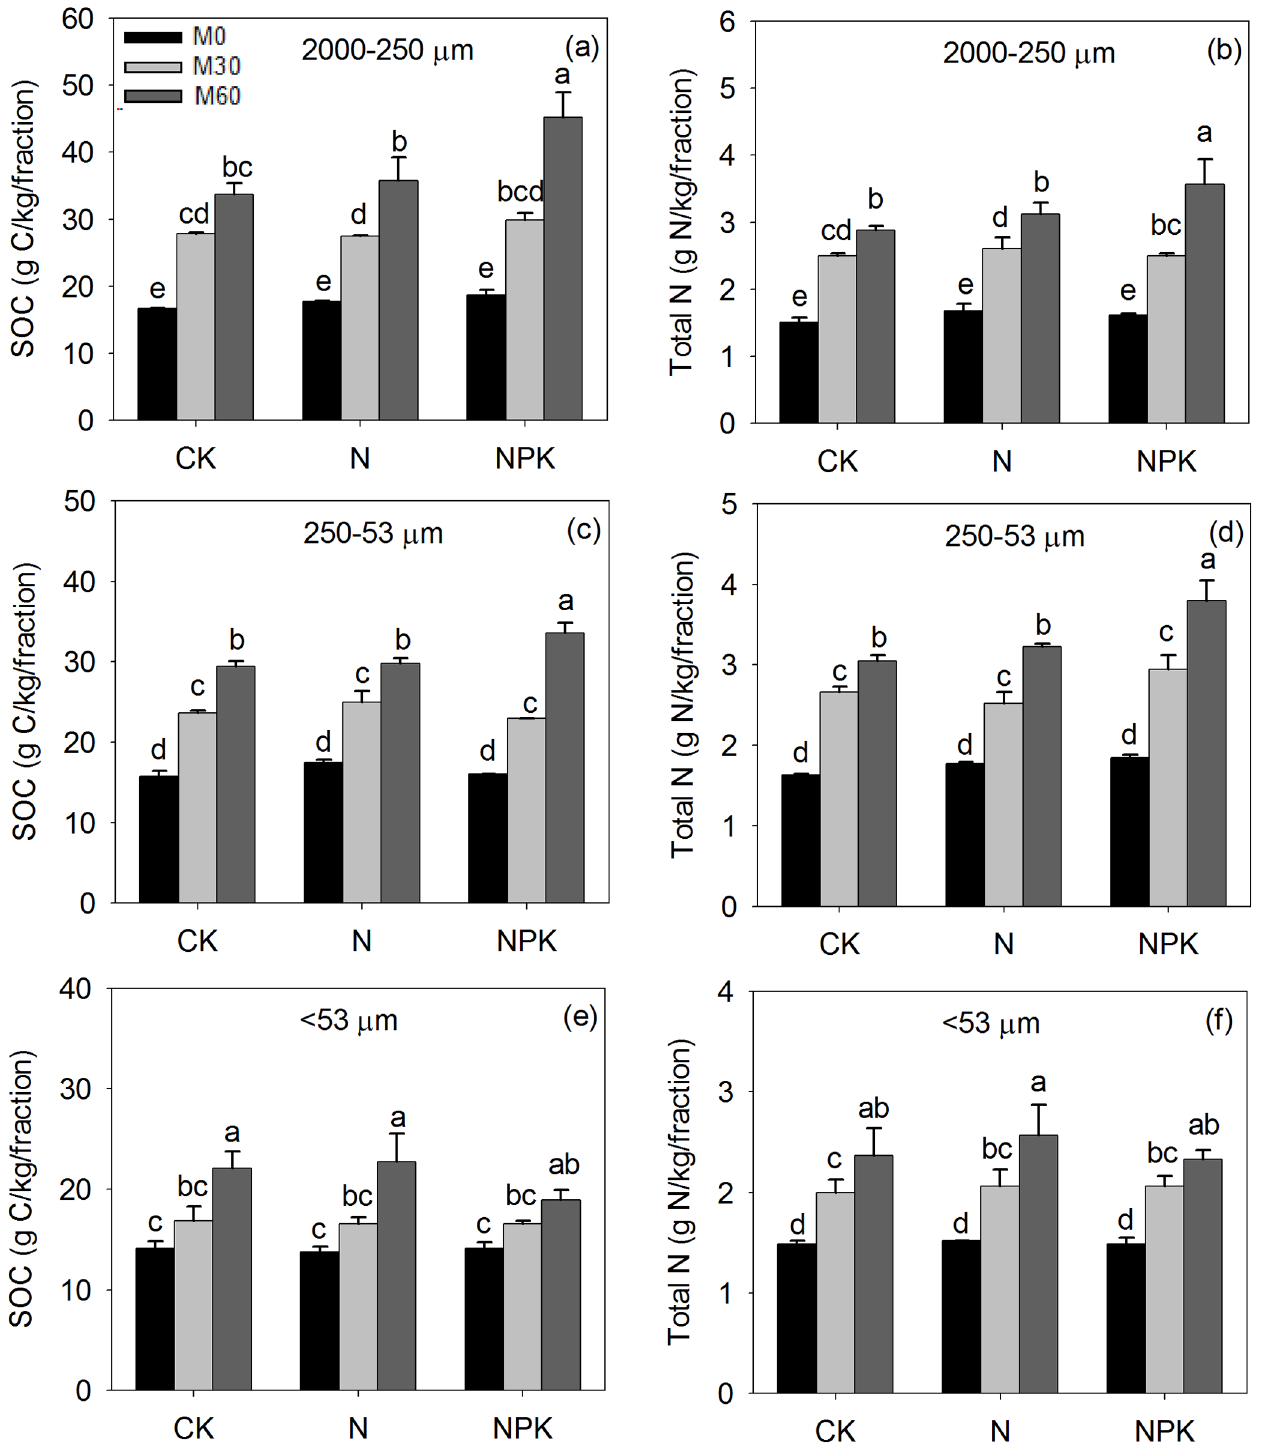
Fig 2. The content of soil organic carbon (SOC) in 2000 – 250 μ m (a), 250 – 53 μ m (c), < 53 μ m (e) fraction and total nitrogen (N) in 2000 – 250 μ m (b), 250 – 53 μ m (d), < 53 μ m (f) fraction from the control (CK) or soil that received 32 years of chemical fertilizer application (N, P: phosphorus, K: potassium) and either 0 (M 0 ), 30 (M 30 ) or 60 (M 60 ) t manure ha -1 yr -1 . Note: Different letters above the bars indicate significant differences at 5% probability level. Capped bars are standard error of the mean (n = 3).